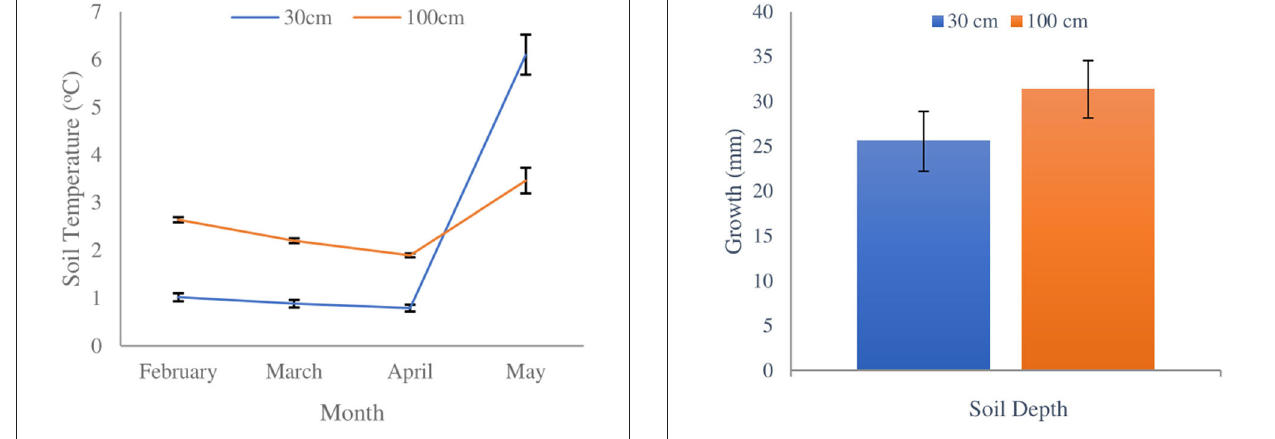
FIGURE 2 | Mean monthly soil temperatures at 30 and 100cm depths within red pine ( Pinus resinosa ) plantations located in Simcoe County, ON. Black bars indicate ± SE.